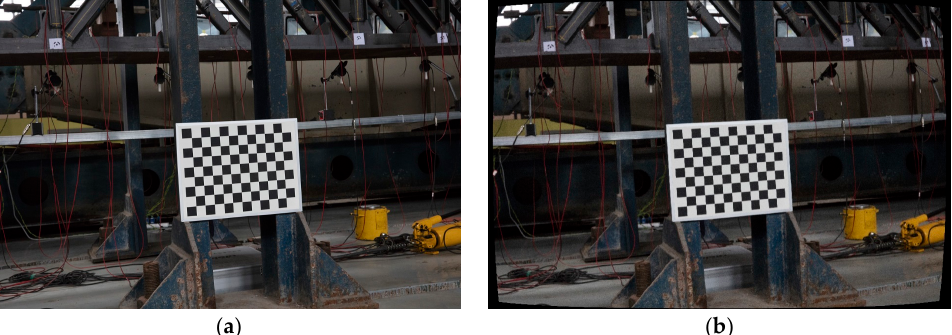
Figure 6. Camera calibration distortion adjustment; ( a ) original image; ( b ) image after distortion correction.